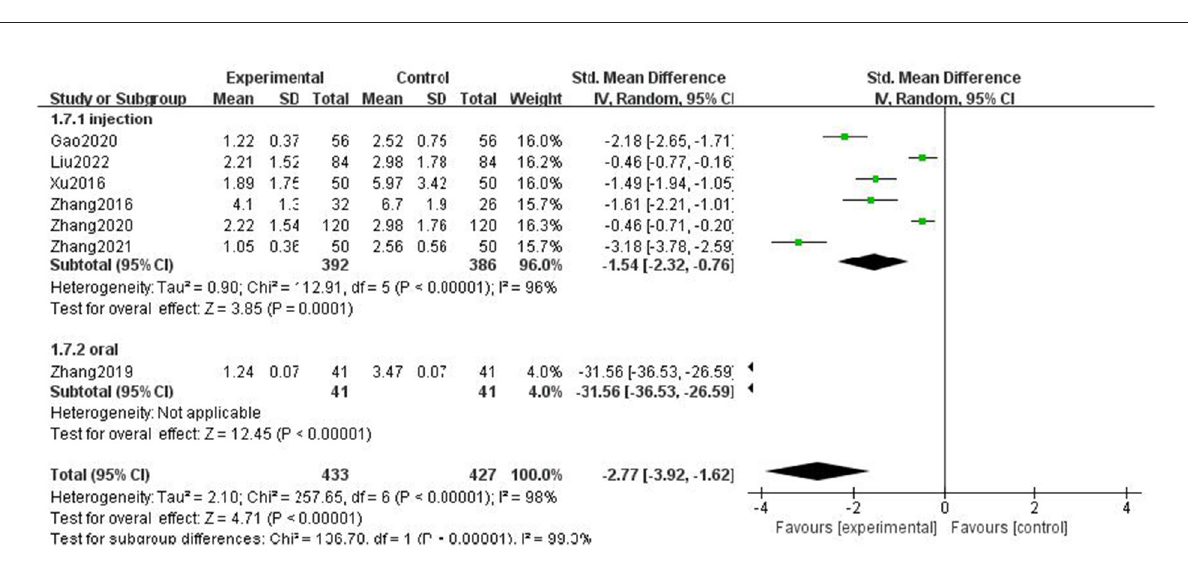
FIGURE12 Forest chart of frequency divided into subgroups according to medication